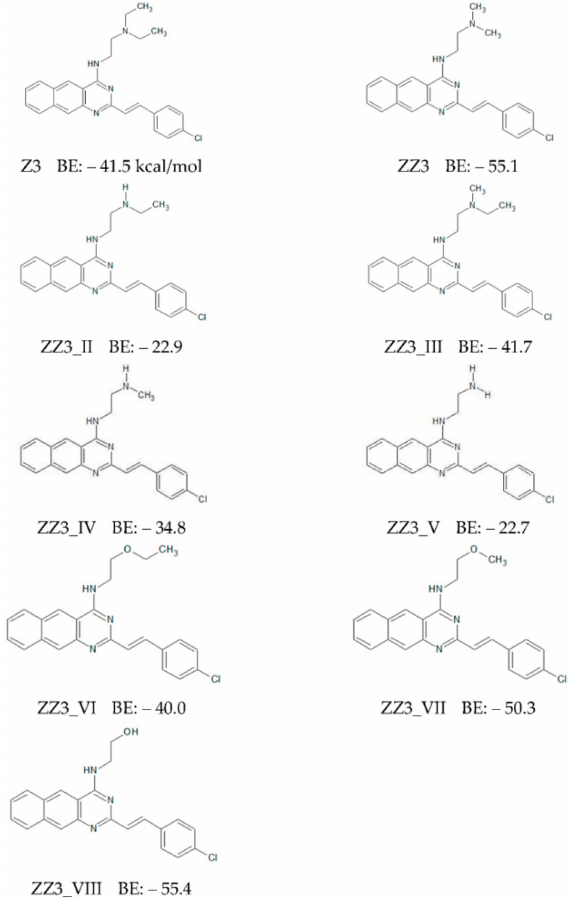
Figure 2. Chemical structures of Z3, ZZ3 and its derivatives with replacing A-part, and their binding energies (BE: kcal / mol) to FtsZ evaluated by ab initio FMO